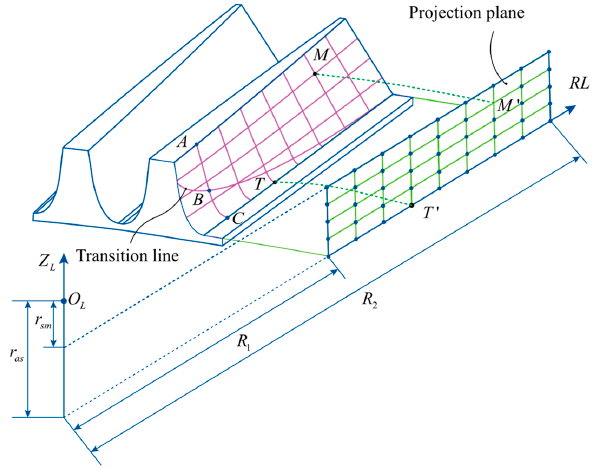
Figure 3. The mapping between the tooth surface and the rotating projection plane. In Figure 3, the point M on the working surface of the face gear is three-dimensional, and its coordinates are ( x M ( θ s , φ s ), y M ( θ s , φ s ), z M ( θ s , φ s )). The corresponding point of M in the rotating projection plane is M ’, and its coordinates are ( RL , ZL ). The equation could be obtained from the rotational projection relation: